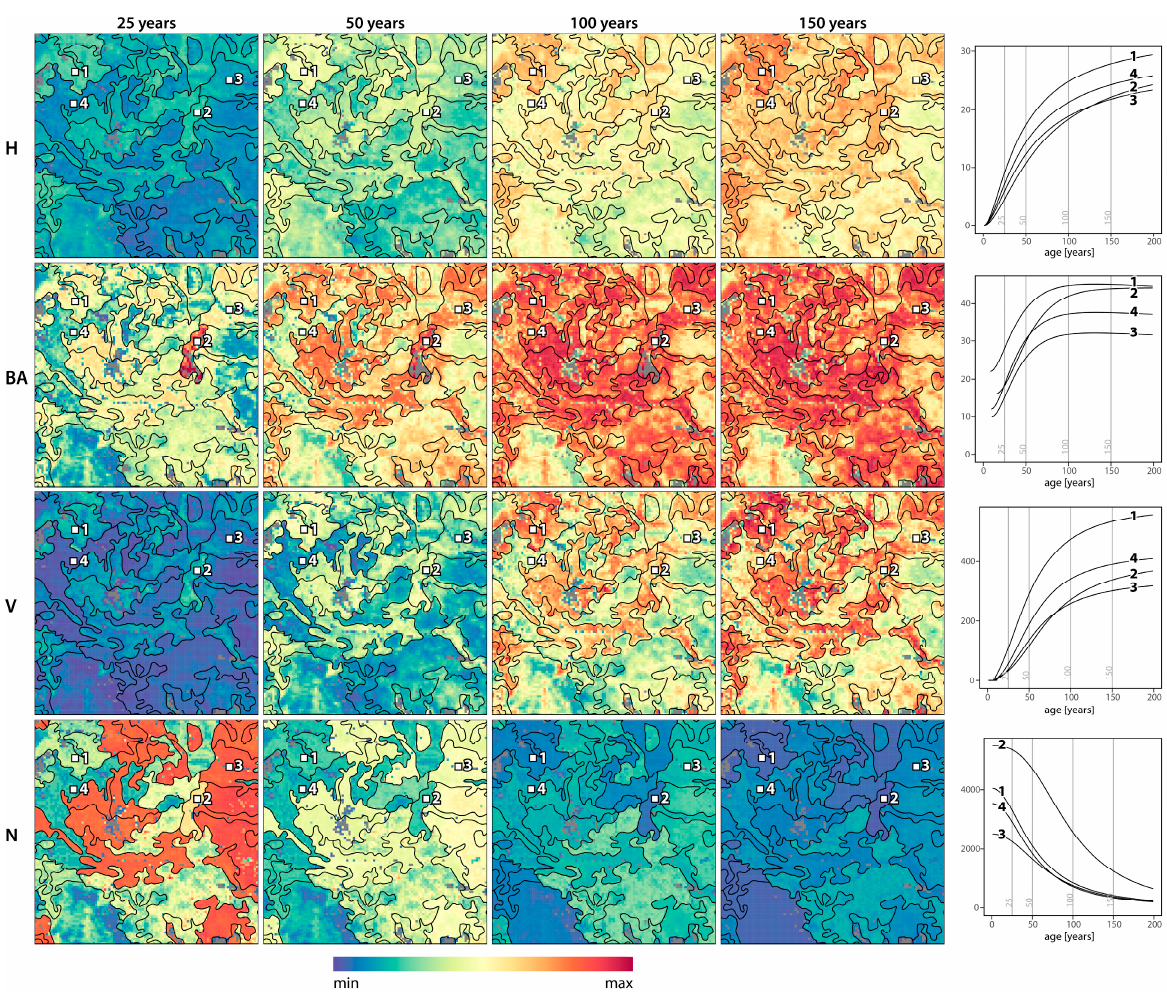
Figure 8. A 2 × 2 km subset of the wall-to-wall yield curve projection result, based on approach 2. Each row of graphs demonstrates a progression of a cell-level attribute (H—top height, BA—basal area, V—total volume, N—stem density) through time. Attributes are projected to 25, 50, 100, and 150 years (columns). Yield curves are shown for four representative cells.